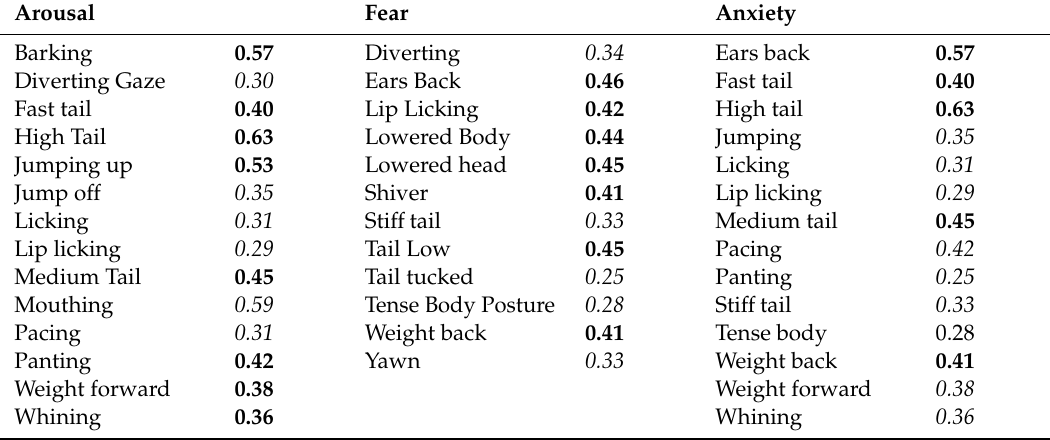
Table 6. Significant ( p < 0.05) Spearman Rank correlation coe ffi cients between behaviours recorded in kennel and the formal behaviour assessment of shelter dogs ( n = 38), listed for the emotional states of Arousal, Fear and Anxiety.